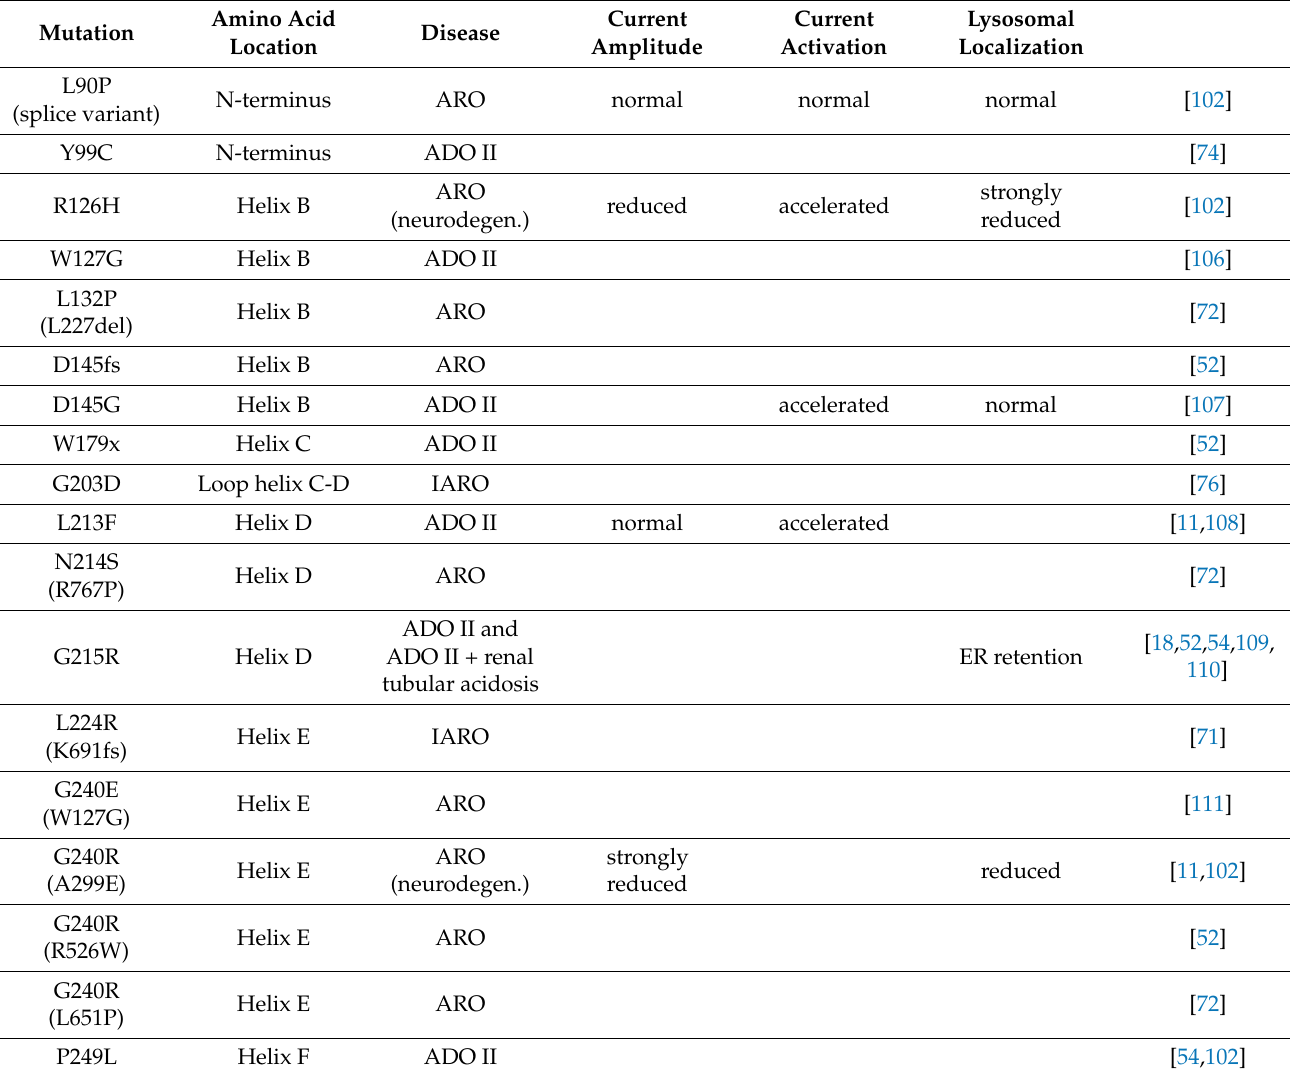
Table 1. List of disease-causing CLCN7